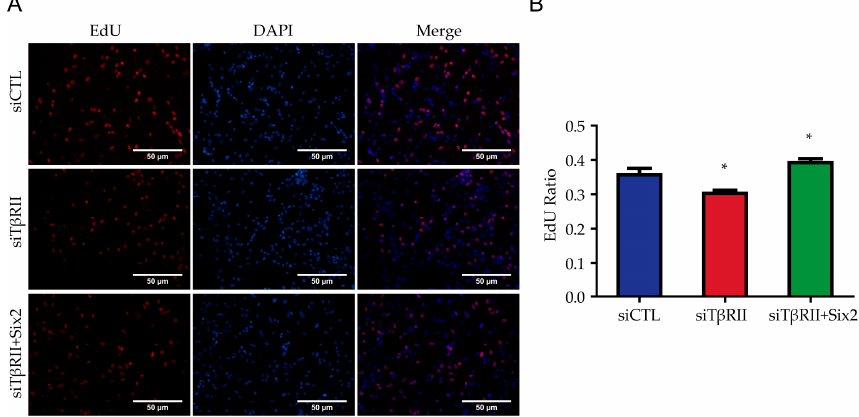
Figure 3. Six2 rescues the proliferation phenotype. ( A ) The proliferation rate of mK3 cells after the transfection of siT β RII and the co-transfection of Six2 ; ( B ) Histogram shows the quantitative analysis of the EdU assay above. All data are displayed as means ± SD from three independent experiments, * p < 0.05.